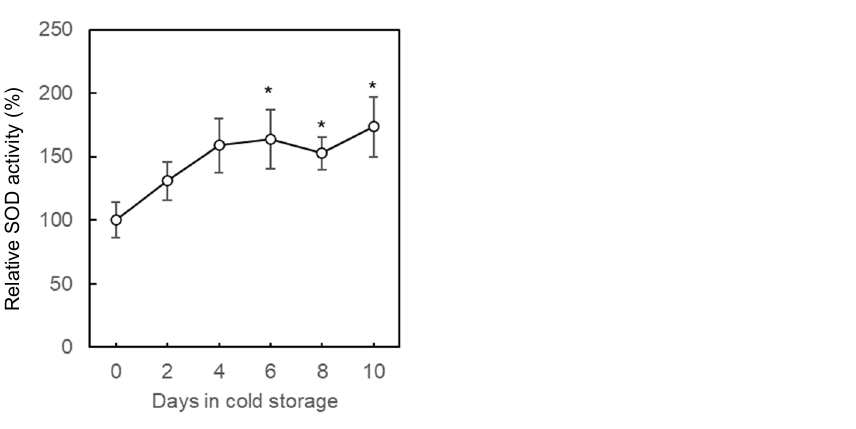
Figure 5. Changes in the superoxide dismutase (SOD) activity of strawberry fruits during cold storage. Harvested strawberry fruits were stored at 0 °C for 10 days with porous film bag. The vertical bar indicates a standard error of six replicates. Asterisks indicate significant differences in comparison to control (0 day) at p = 0.05 * with Wilcoxon test.